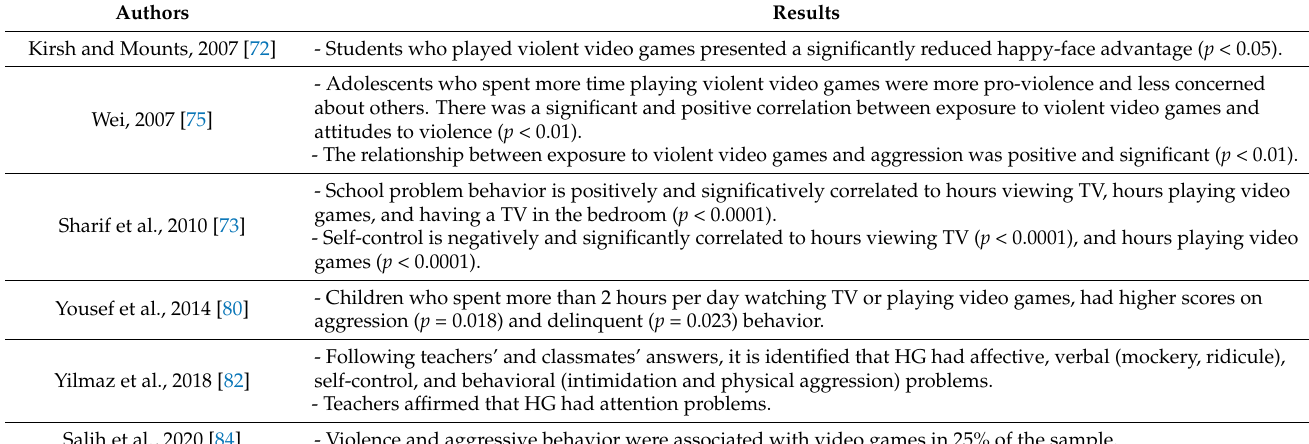
Table 4. Results related to aggressive